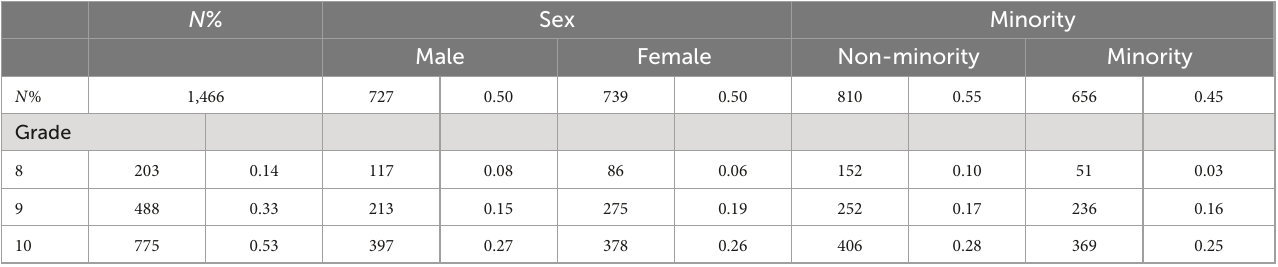
TABLE 1 Descriptive statistics for demographic